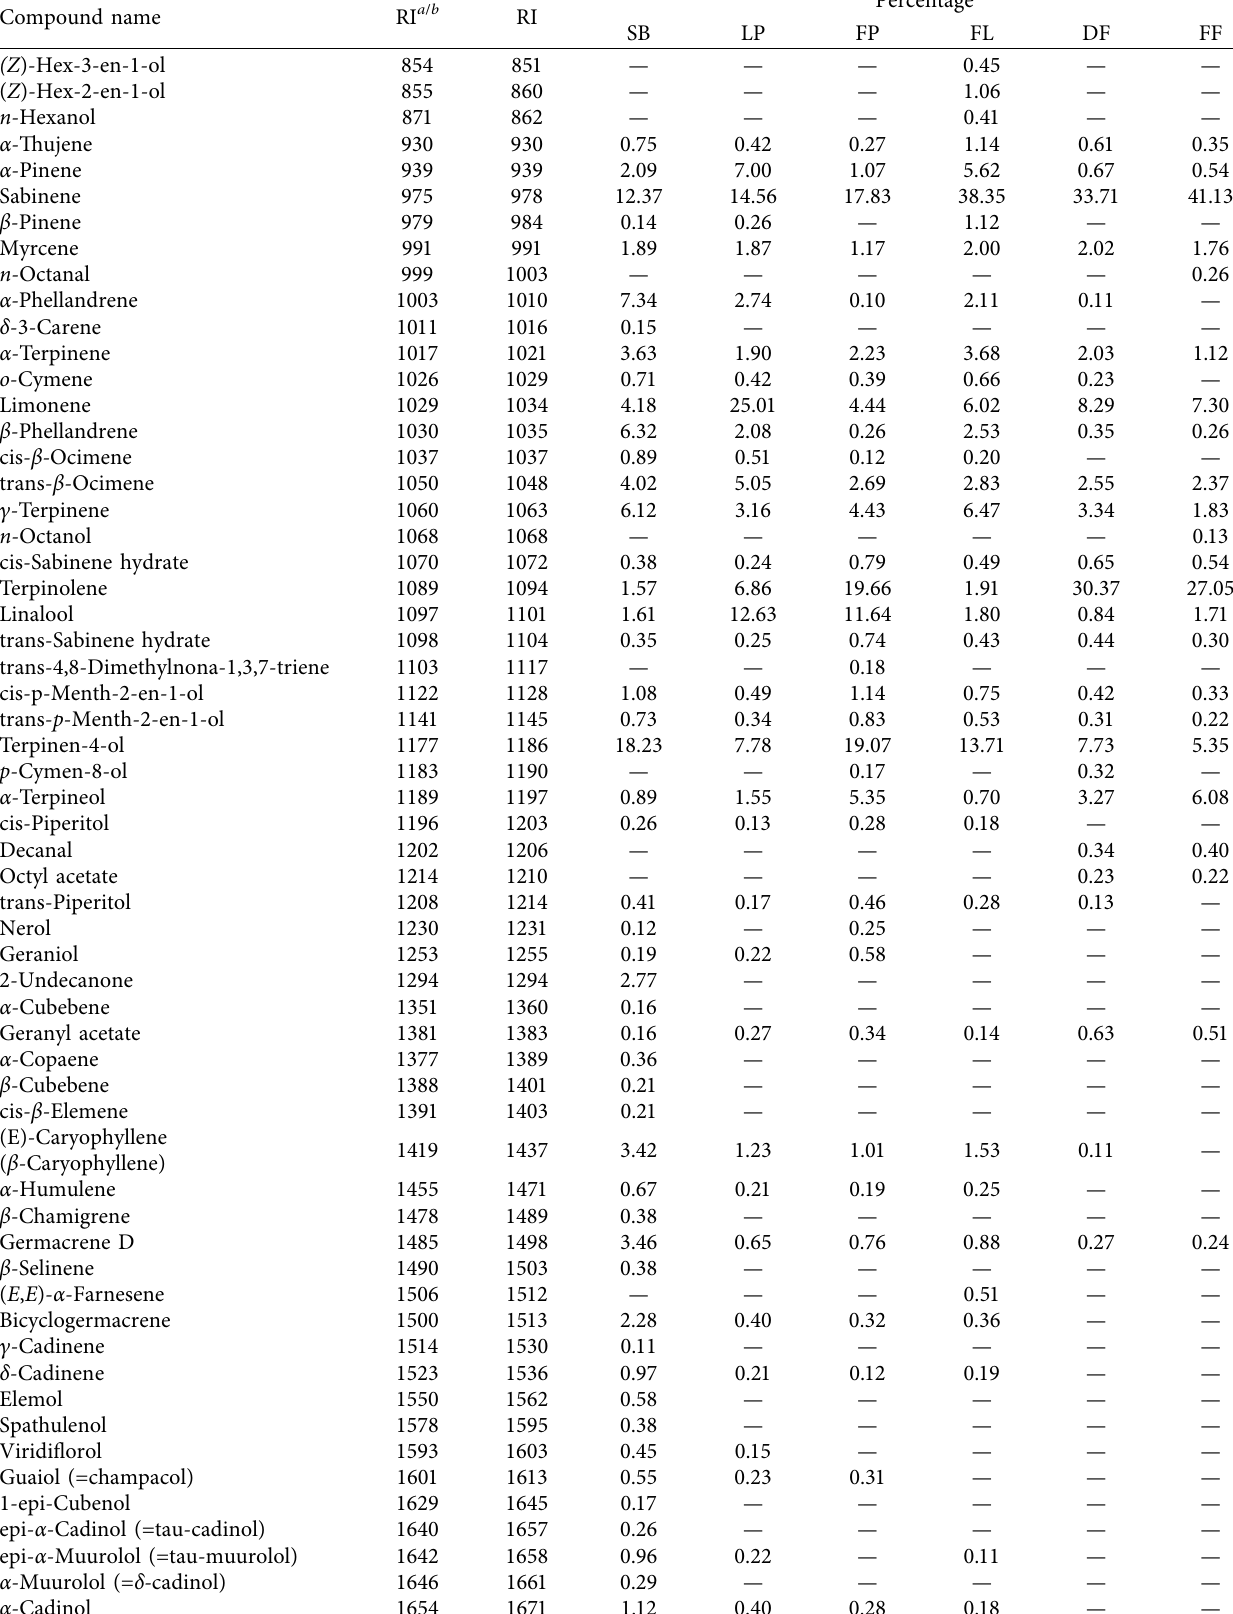
Table 1: Phytochemical profile of EOs from the different parts of Z. rhetsa